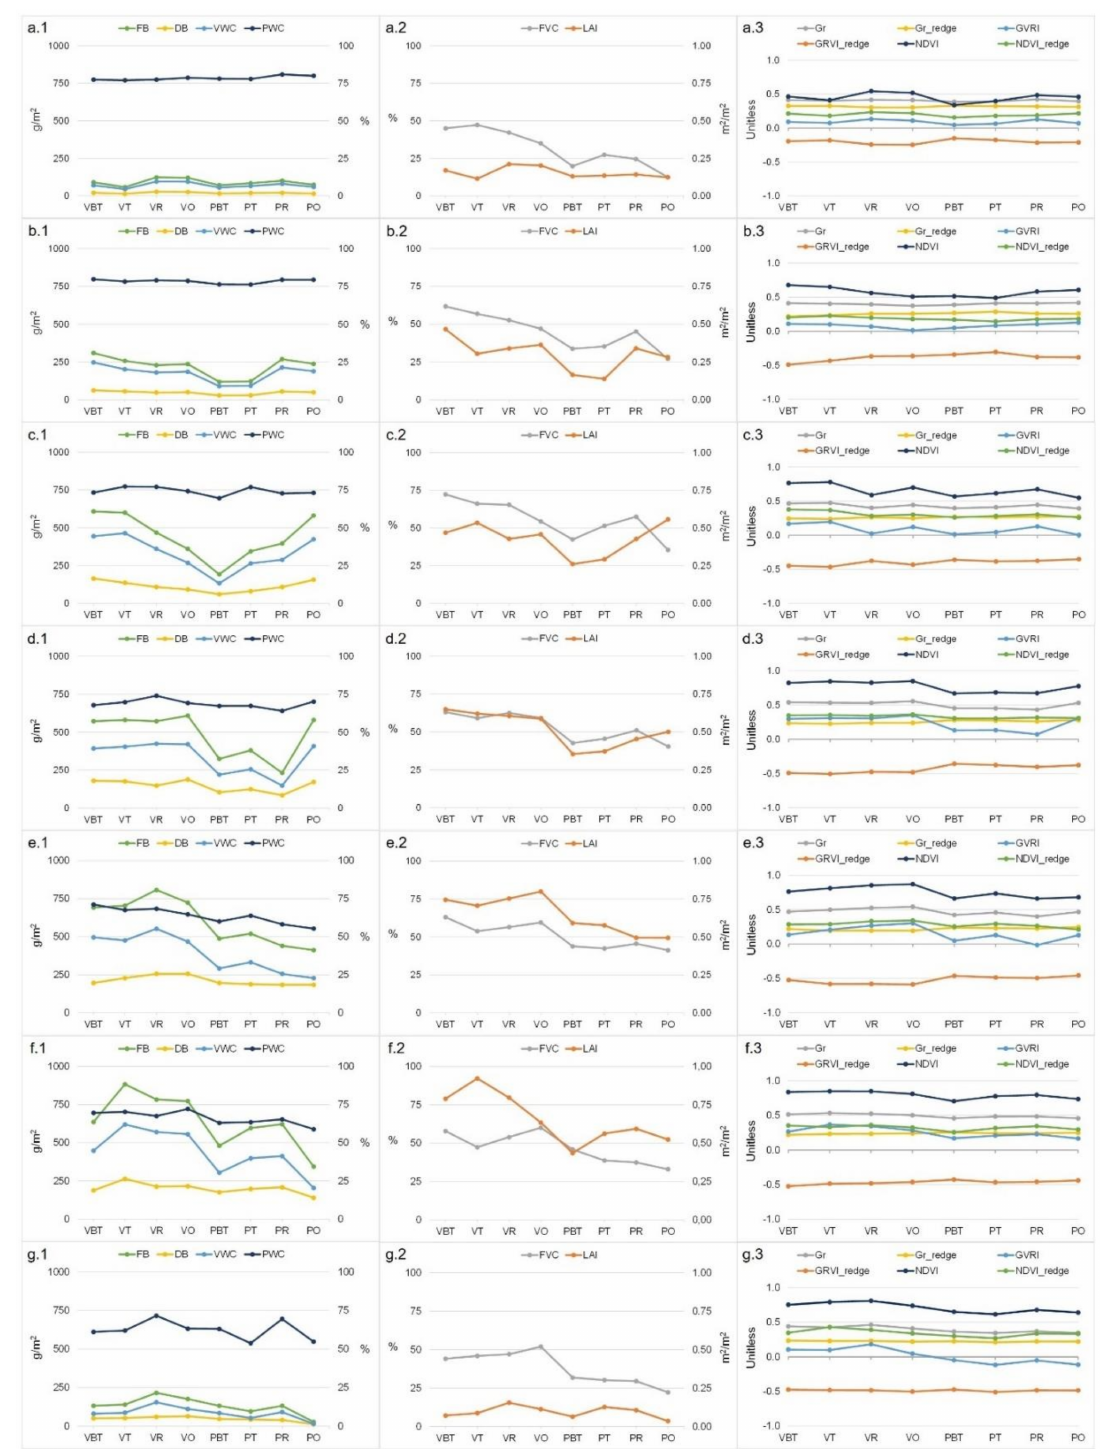
Figure A1. Field estimations and spectral indices for the associations at each of the seven measurement dates. Letter ( a ) correspond to 4 February 2020, ( b ) to 26 February 2020, ( c ) to 26 March 2020, ( d ) to 14 April 2020, ( e ) to 2 May 2020, ( f ) to 17 May 2020 and ( g ) to 29 May 2020. FB: fresh biomass, DB: dry biomass, VWC: vegetation water content, PWC: percentage of water content, VBT: vetch-barley-triticale, VT: vetch-triticale, VR: vetch-rye, VO: vetch-oats, PBT: pea-barley-triticale, PT: pea-triticale, PR: pea-rye and PO: pea-oats. Subfigure 1 show, FB, DB, VWC and PWC, Subfigure 2 show FVC and LAI and Subfigure 3 show the vegetation